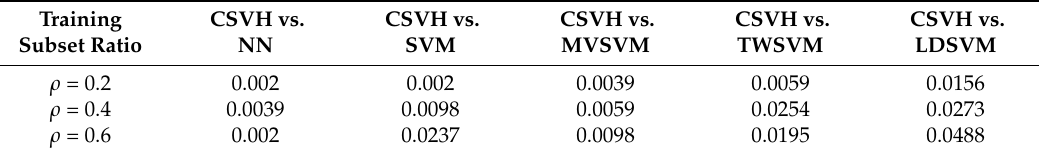
Table 5. p -Values of the Wilcoxon signed-ranks test between CSVH and other classifiers (significance level α = 0.05).